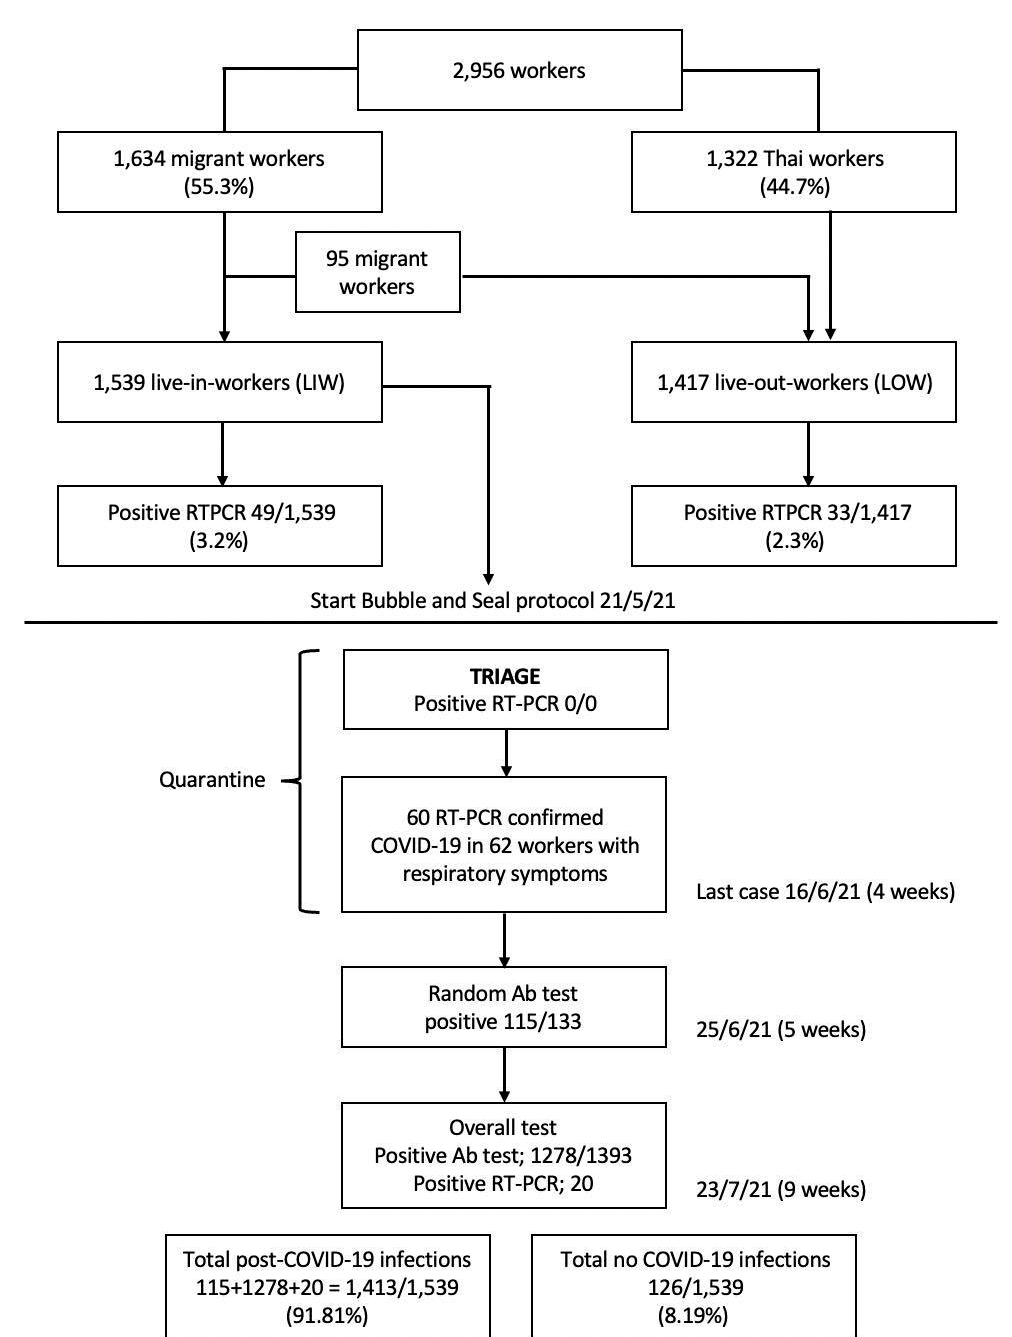
Figure 3. Flow chart of the COVID-19 situation of the factory before and during the Bubble and Seal